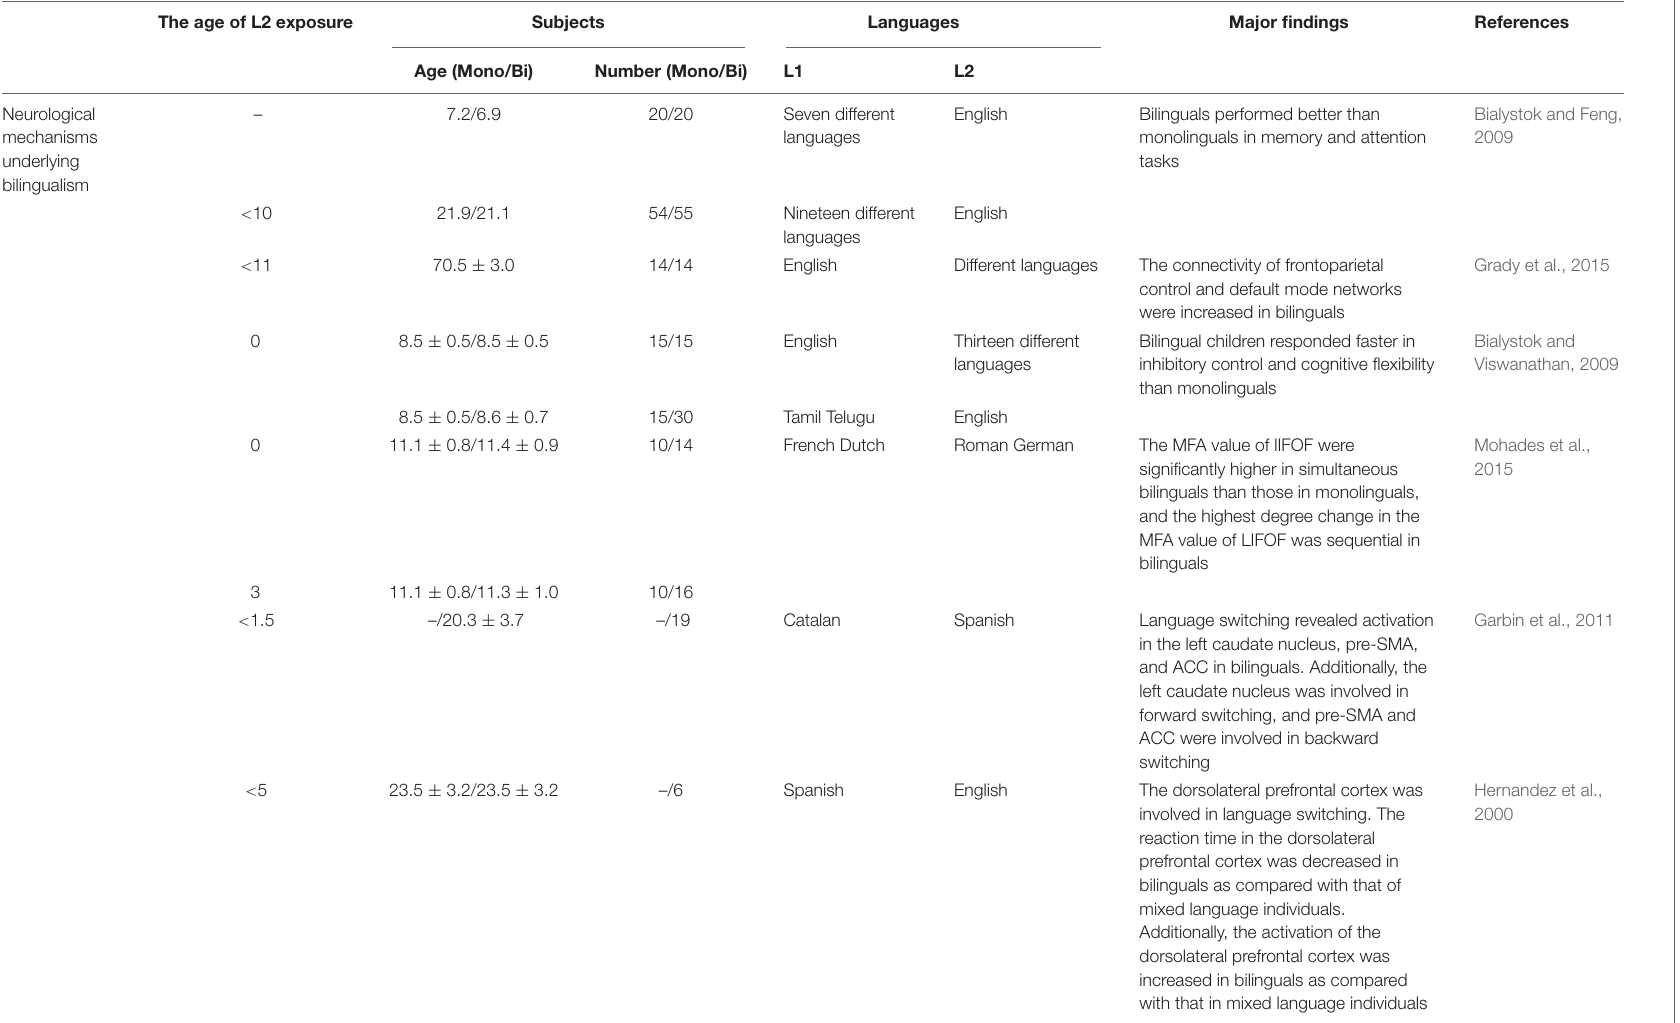
TABLE 3 | The effects of bilingualism: neurological and structural changes in the brain. The age of L2 exposure Subjects